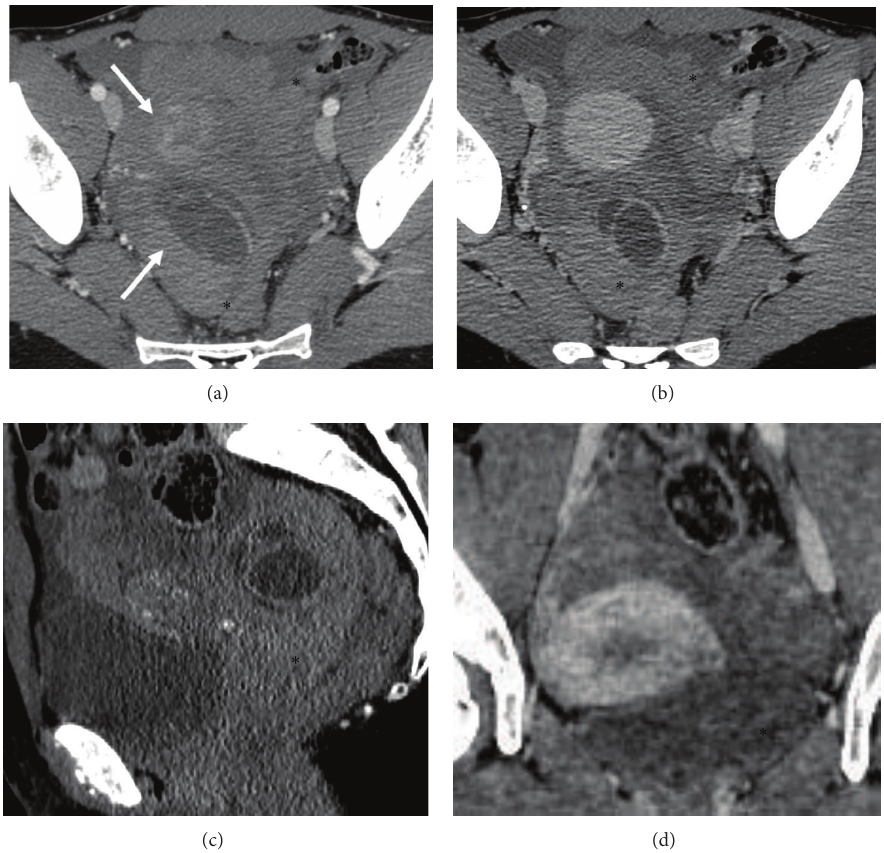
Figure 3: Dynamic contrast-enhancement CT scan. After injection of contrast medium pelvic CT images ((a, b) axial image; (c) sagittal image; (d) coronal image) show thickening and contrast-enhanced bilobate cystic wall in the right adnexa. The early arterial phase shows cloud-like extravasation from this lesion indicating active bleeding (arrows). Dynamic CT scan confirms diffuse hemoperitoneum ( ∗